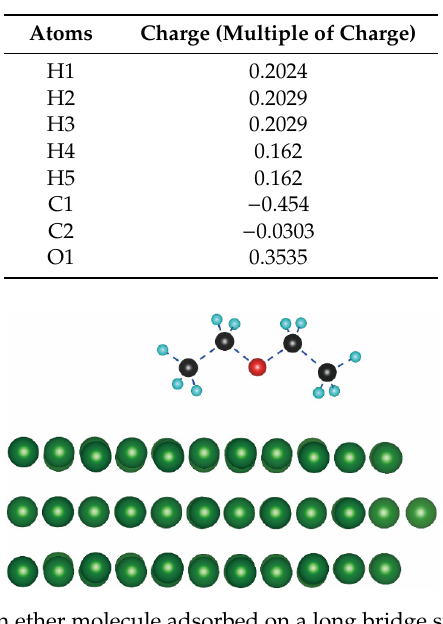
Figure 3. The chemical configuration of ether molecule with its labelled atoms. Table 1. The charge information of atoms in ether.